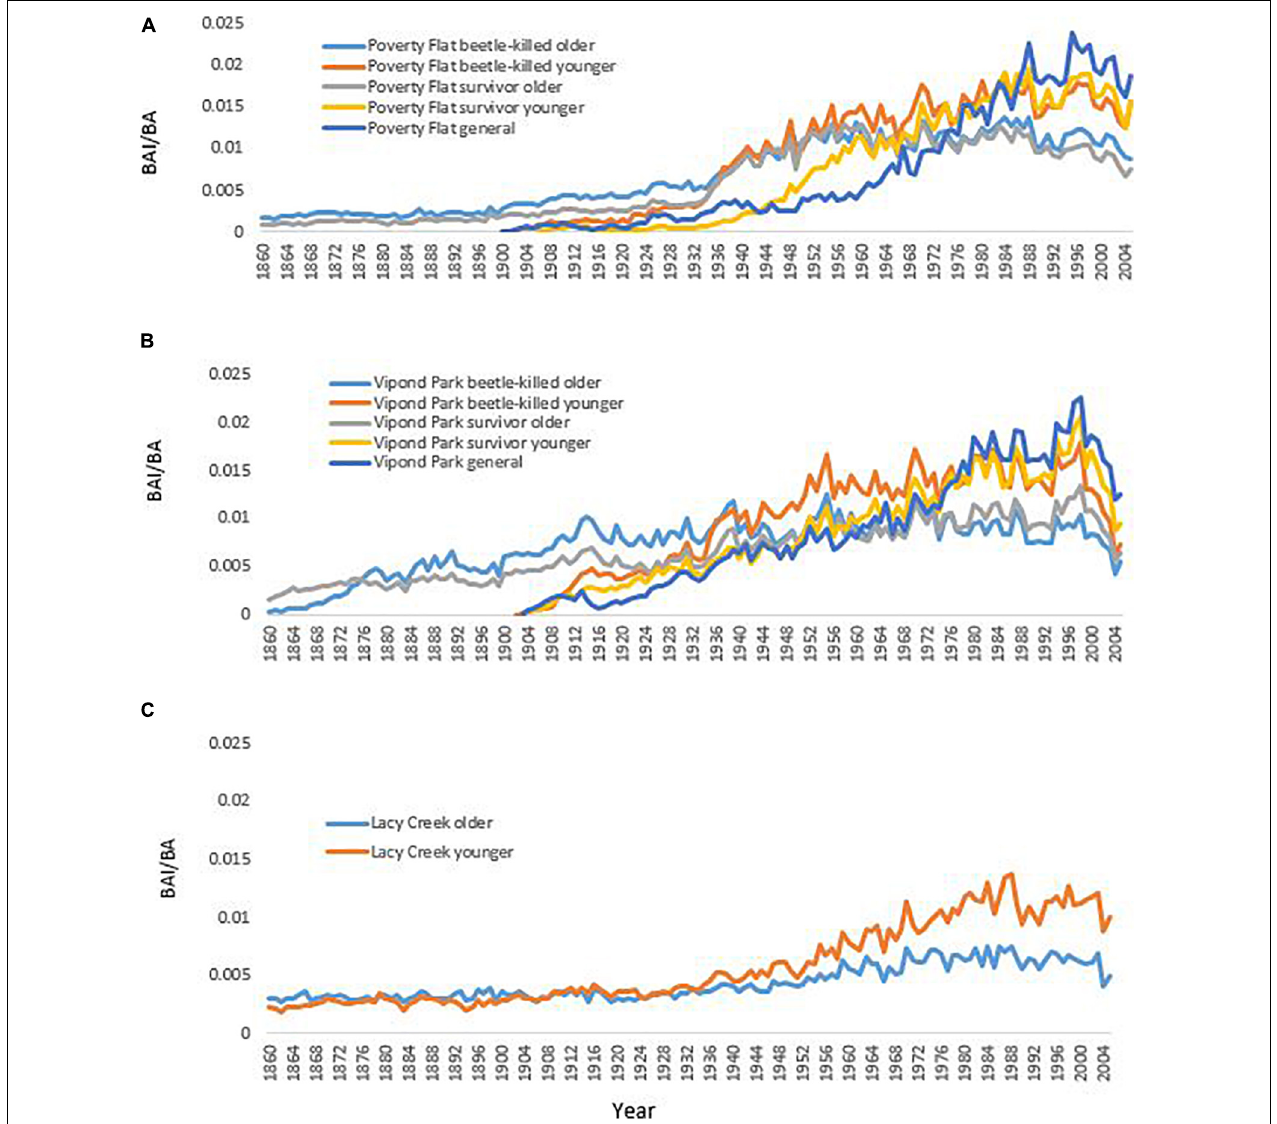
FIGURE 4 | Growth of different categories of Pinus albicaulis as measured by basal area increment (BAI)/basal area (BA) at (A) Poverty Flat, ID, (B) Vipond Park, MT, and (C) Lacy Creek, MT. (Mean diameter and relative age of trees in each category presented in Supplementary Appendix 2